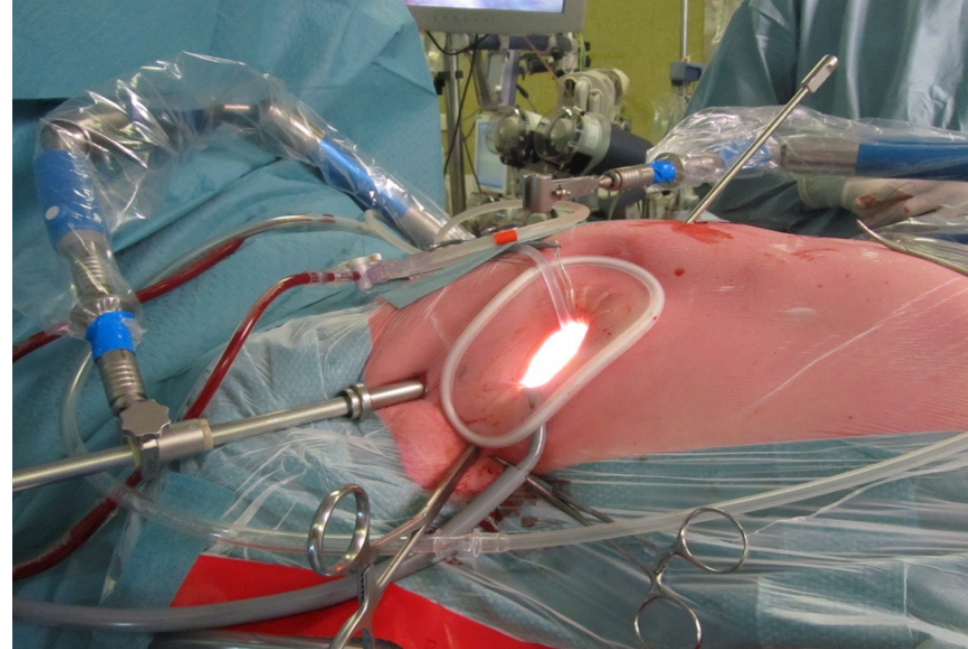
Figure 3. Setup of a MIMVS procedure by right anterolateral mini thoracotomy. Starting from the bottom of the soft tissue retractor in clockwise direction: Carbon dioxide insufflator, Transthoracic Chitwood clamp, video port and left atrial retractor.